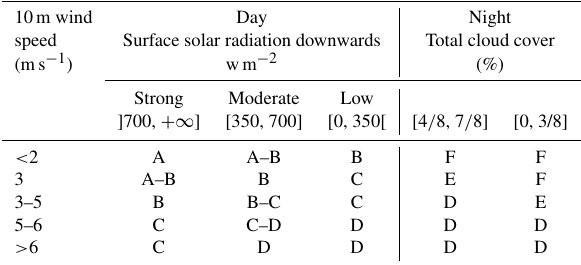
Table A1. Pasquill classes according to the method of Turner.